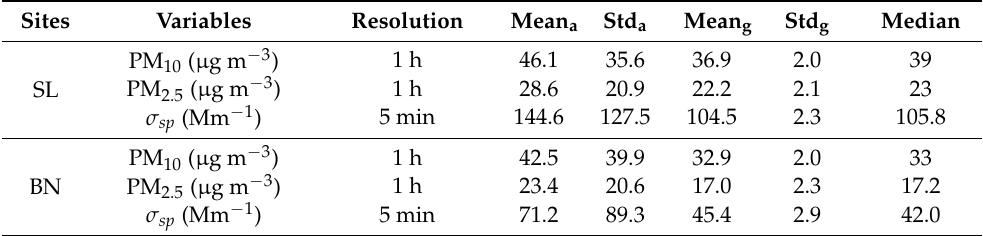
Table 1. Summary of mean, standard deviation, and median of PM 10 , PM 2.5 , and σ sp at Seoul (SL) and Baengnyeongdo (BN) from 2011 to 2016.